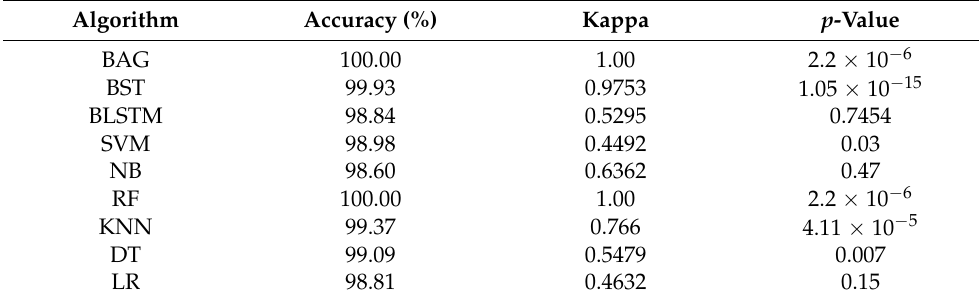
Table 5. Performance of AENN on BAG, BST, BLSTM, SVM, NB, RF, KNN, DT, and LR.